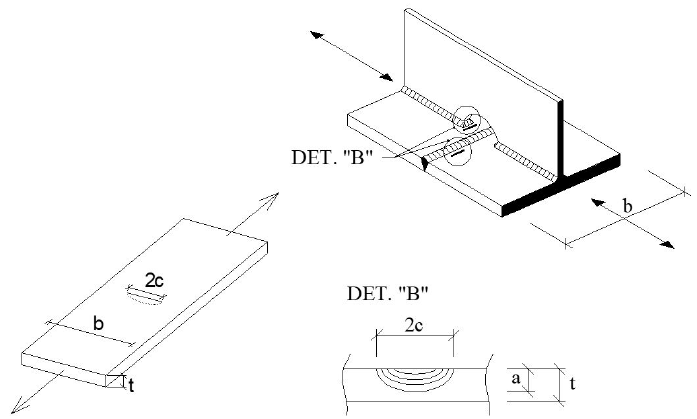
Figure 1. Crack propagated from